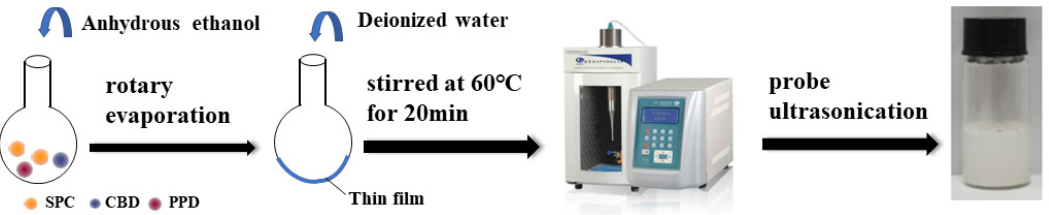
Figure 2. The preparation of CP-liposomes and GMCP-liposomes.